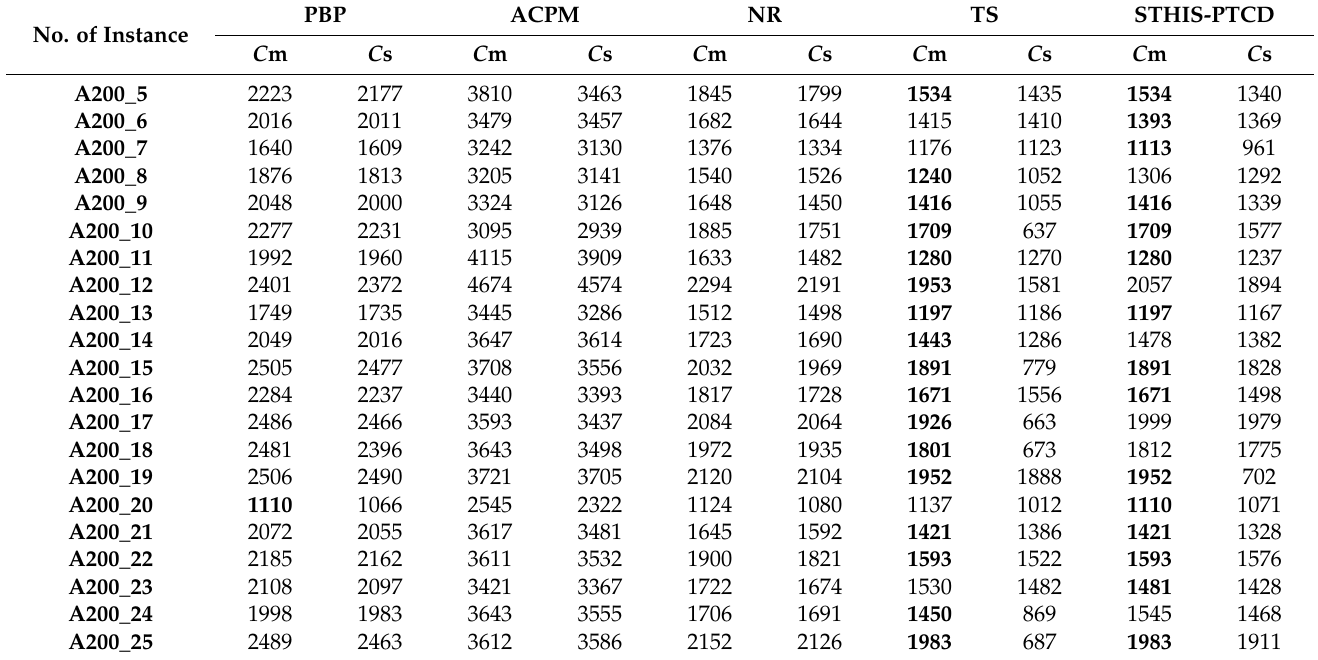
Figure 25. Results of the PBP, ACPM, NR, TS, and STHIS ‐ PTCD for 100 instances: ( a ) 20 operations; ( b ) 50 operations;.( c ) 100 operations; ( d ) 200 operations.